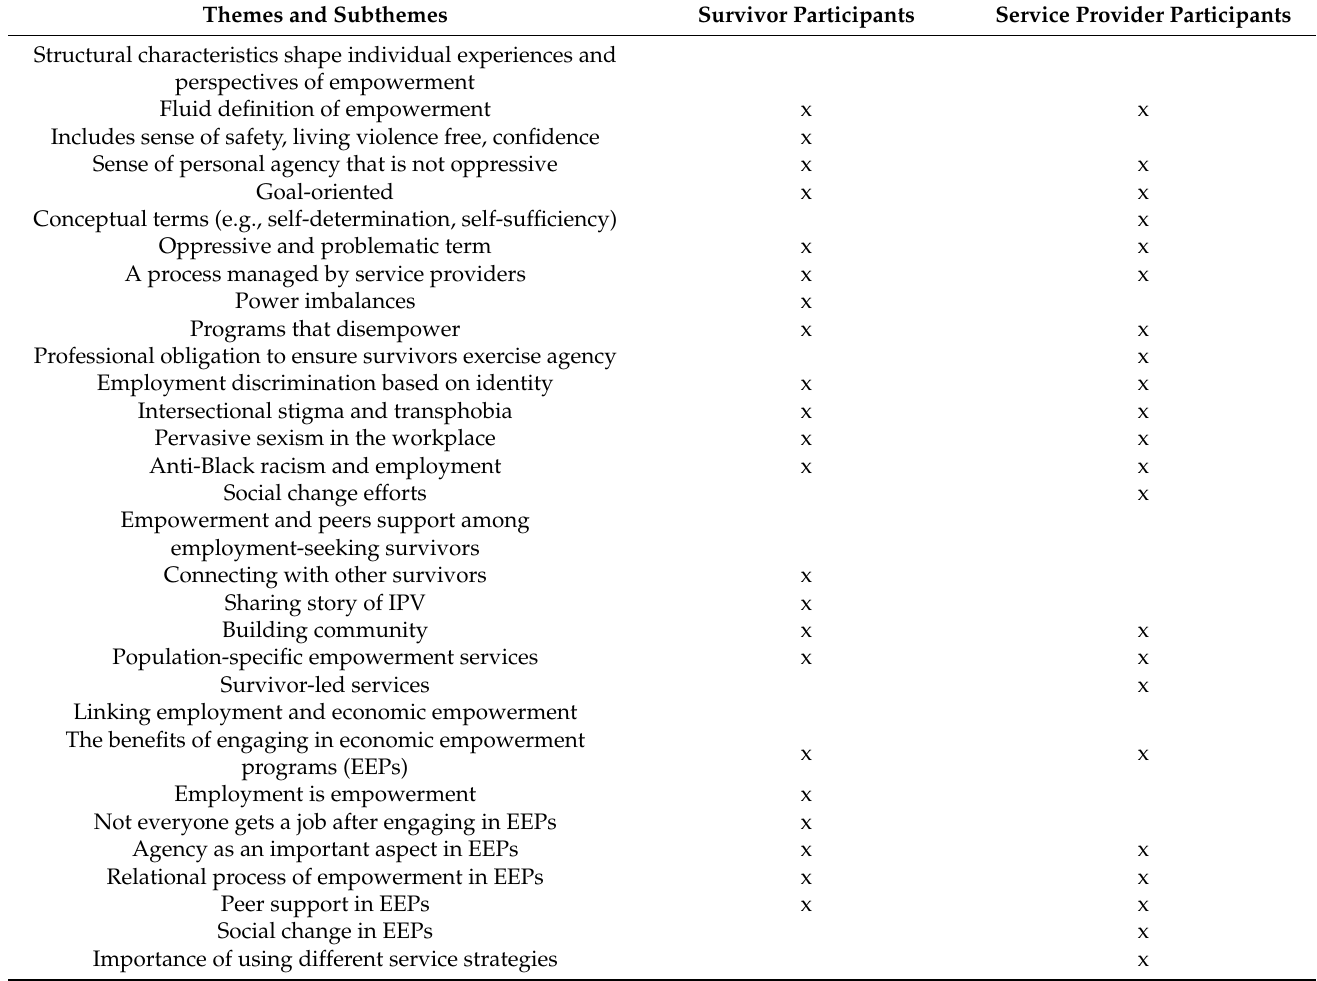
Table 1. Themes and subthemes of empowerment mapped across both groups of